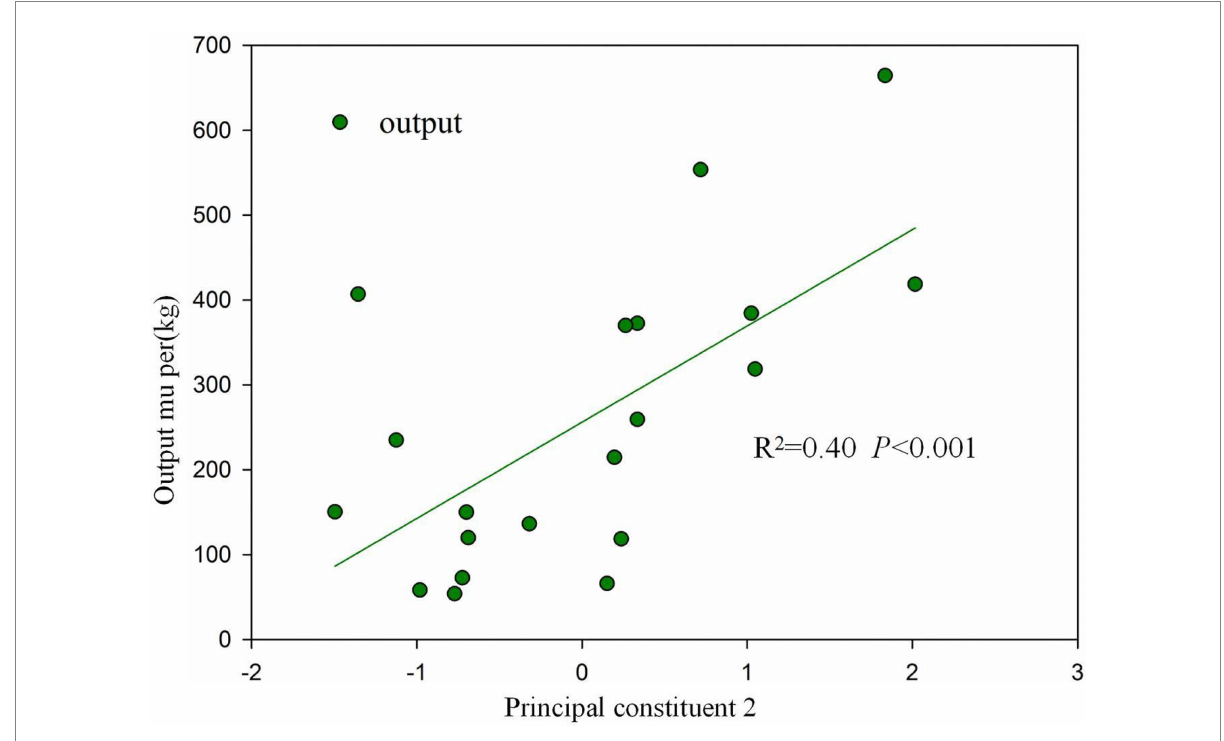
FIGURE 2 Relationships between forage output and Principal component